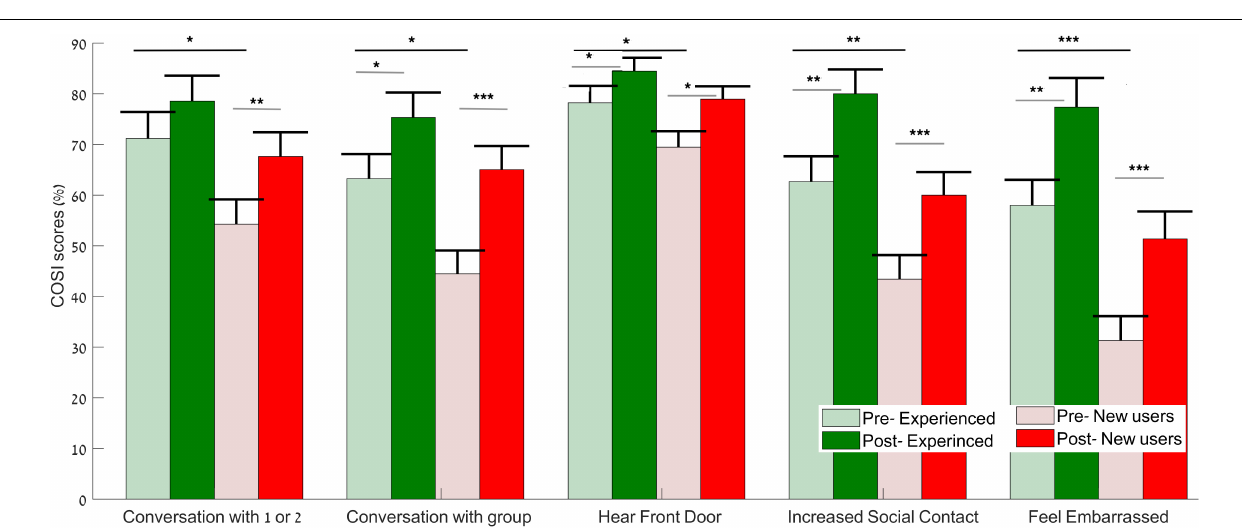
FIGURE 4 | Client Oriented Scale of Improvement (COSI) mean score (%) for the experienced (green) and new users (red) obtained from the pre- (light bars) and post- (dark bars) reports across the five listening situations: “Conversation with 1 or 2 in Noise,” “Conversation with Group in Noise,” “Hear Front Door Bell or Knock,” “Increased Social Contact,” “Feel Embarrassed.” Error bars represent standard error of the mean. Dark lines indicate main group effects as indicated by ANOVA- overall scores. Gray lines indicate within group comparisons, * p < 0.05, ** p < 0.01, *** p <